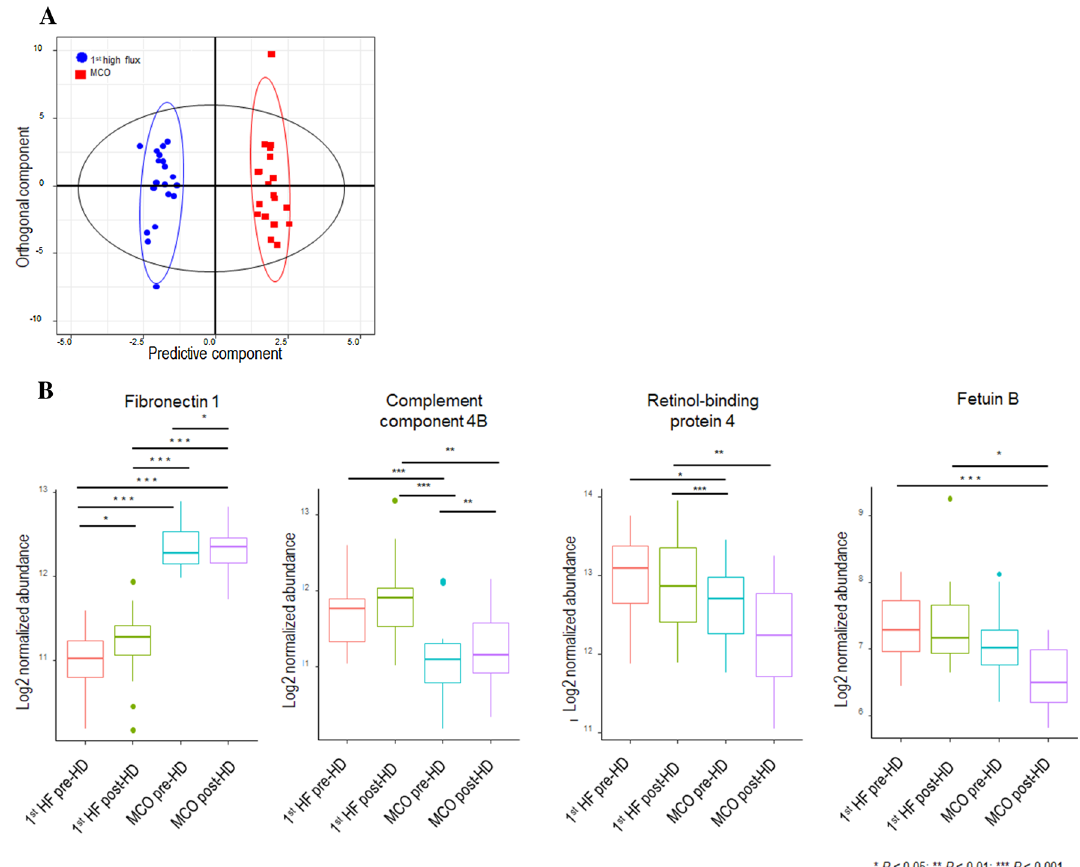
Figure 3. Proteomic differences between the 1st HF and MCO dialyzer periods. ( A ) OPLS-DA score scatter plot derived from the 1 H NMR spectra of pre-dialysis plasma obtained from subjects in the 1st HF and MCO dialyzer periods. In the OPLS-DA result, the score scatter plot (R 2 = 0.975, Q 2 = 0.591) shows a substantial separation of the 1st HF (blue circle) and MCO (red square) dialyzer periods suggesting significant differences between these groups. ( B ) Pre-HD and post-HD normalized protein abundance between 1st HF and MCO dialyzer periods. The P values were calculated using the paired t-test using RStudio (version 1.1.456) in R (version 3.6.0): * < 0.05, ** < 0.01, *** < 0.001. The statistical R software packages used included ggplot2 for drawing plots, stats for calculating t-test values, and ropls-package for OPLS-DA for multivariable analysis and feature selection. OPLS-DA, orthogonal partial least-squares discriminant analysis; NMR, nuclear magnetic resonance; HF, high flux; MCO, medium cut-off; VIP, variable important in projection; HF, high flux; HD,